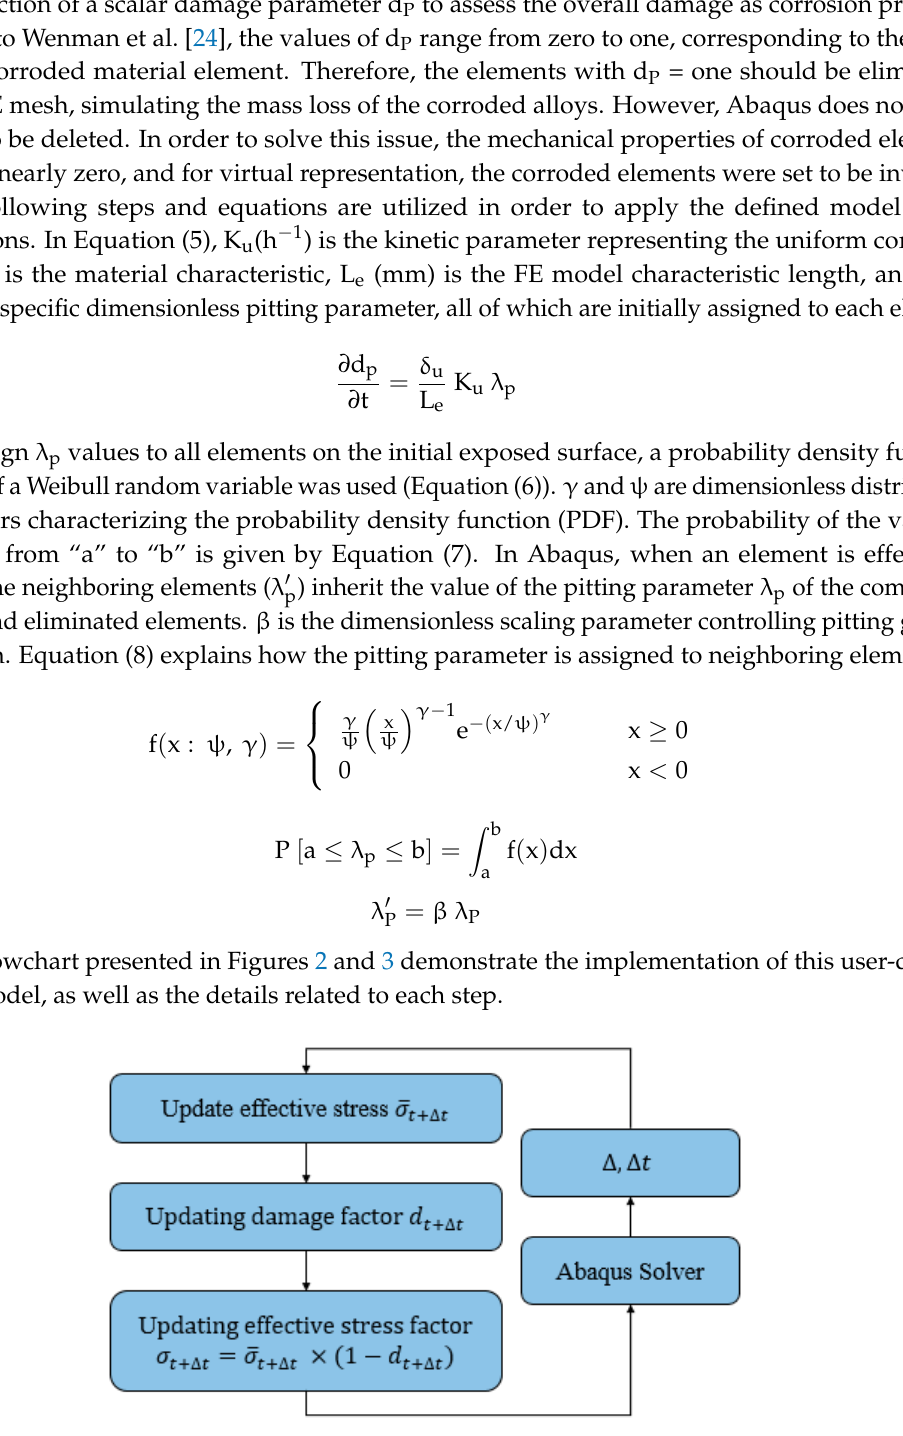
Figure 2. Schematic overview of the steps toward generating the VUMAT code.